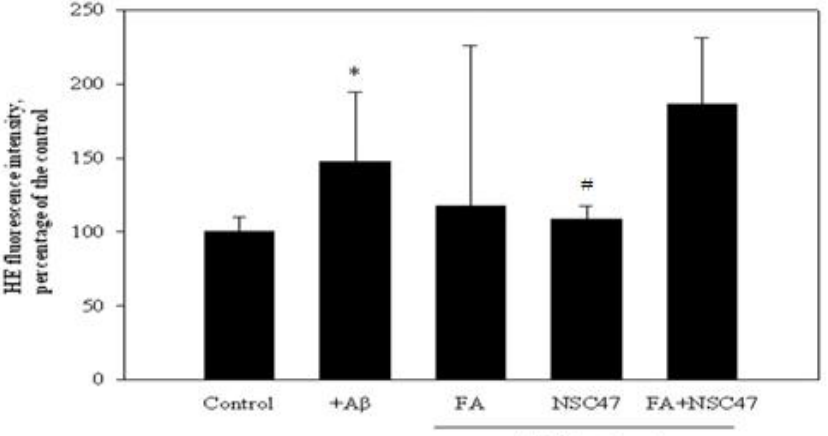
Figure 4. Effects of folic acid (FA) or/and NSC47 on superoxide production by β -amyloid (A β )-treated C13NJ